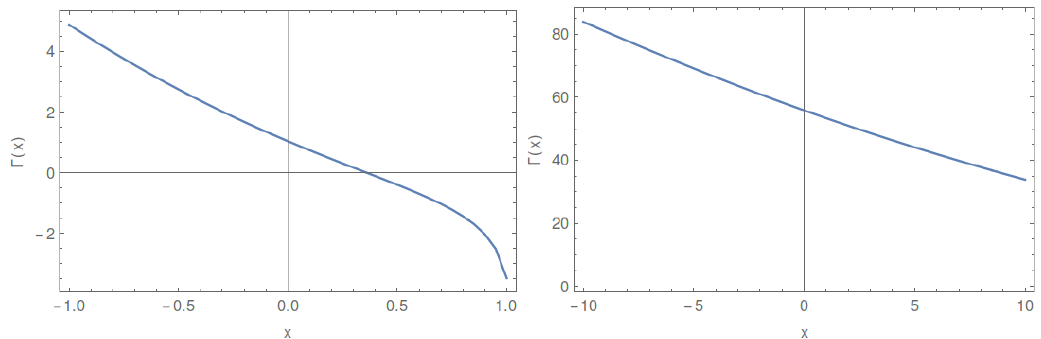
Figure 3: The left plot is when c = 1, and Γ ( x ) can have negative values. The right plot is when c = 10, and Γ ( x ) is positive for the eigenvalue interval. In both plots, f = 1 is